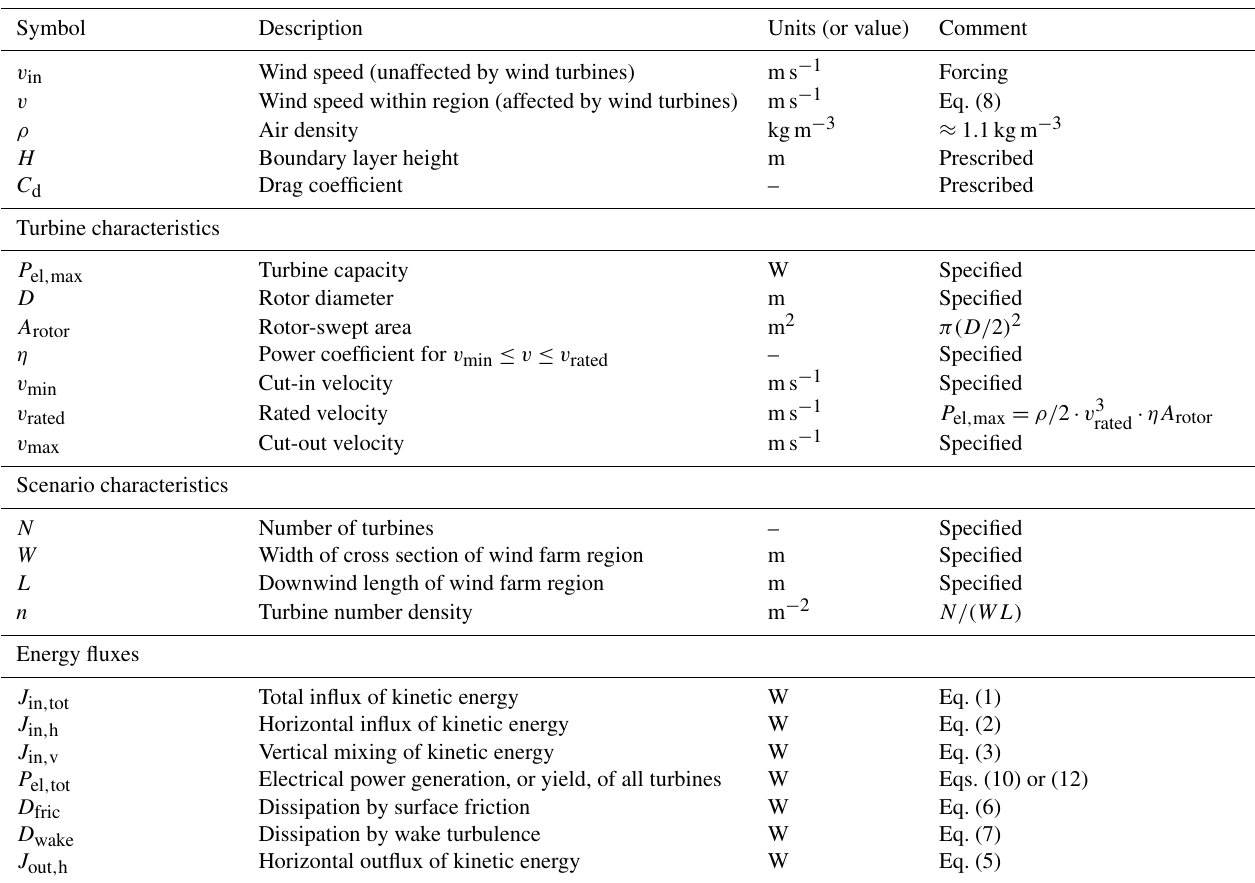
Table 1. Overview of KEBA variables and how these are specified or computed.